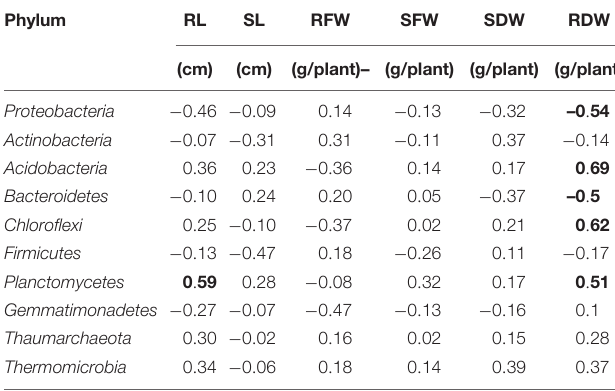
TABLE 5 | Pearson’s coefficients of correlation ( r ) between the 10 most abundant phyla of soil bacteria and measures of peanut growth. Phylum RL SL RFW SFW SDW RDW